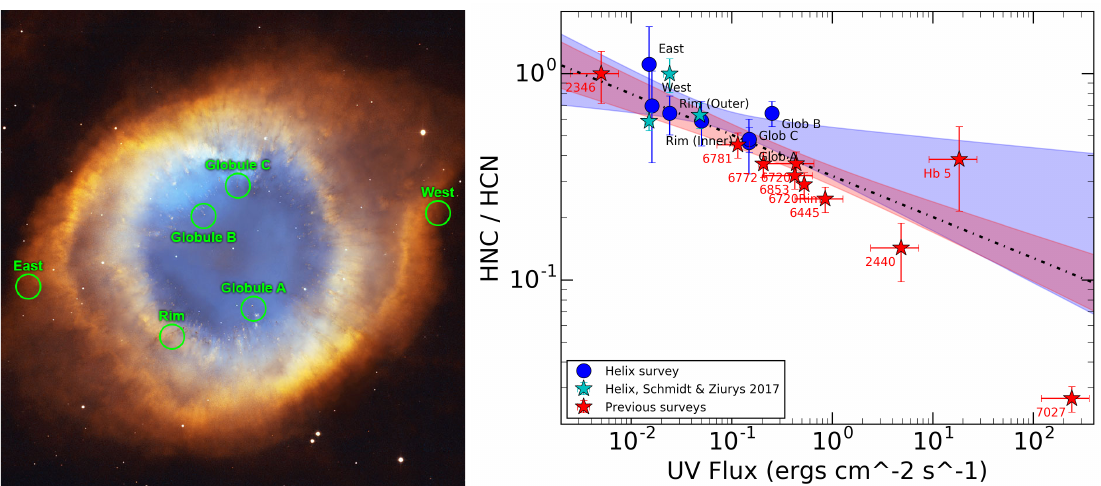
Figure 1. ( Left ) HST optical image of the Helix Nebula (NASA, NOAO, ESA, the Hubble Helix Nebula Team, M. Meixner (STScI), and T.A. Rector (NRAO)), with positions and beam widths of our 30 m observations indicated (circles). ( Right ) HNC/HCN line intensity ratio vs. CSPN UV flux for the Helix Nebula and previous PNe survey sources. Linear regression fits to Helix survey data (blue) and entire data set (red) are displayed with 1 σ errors